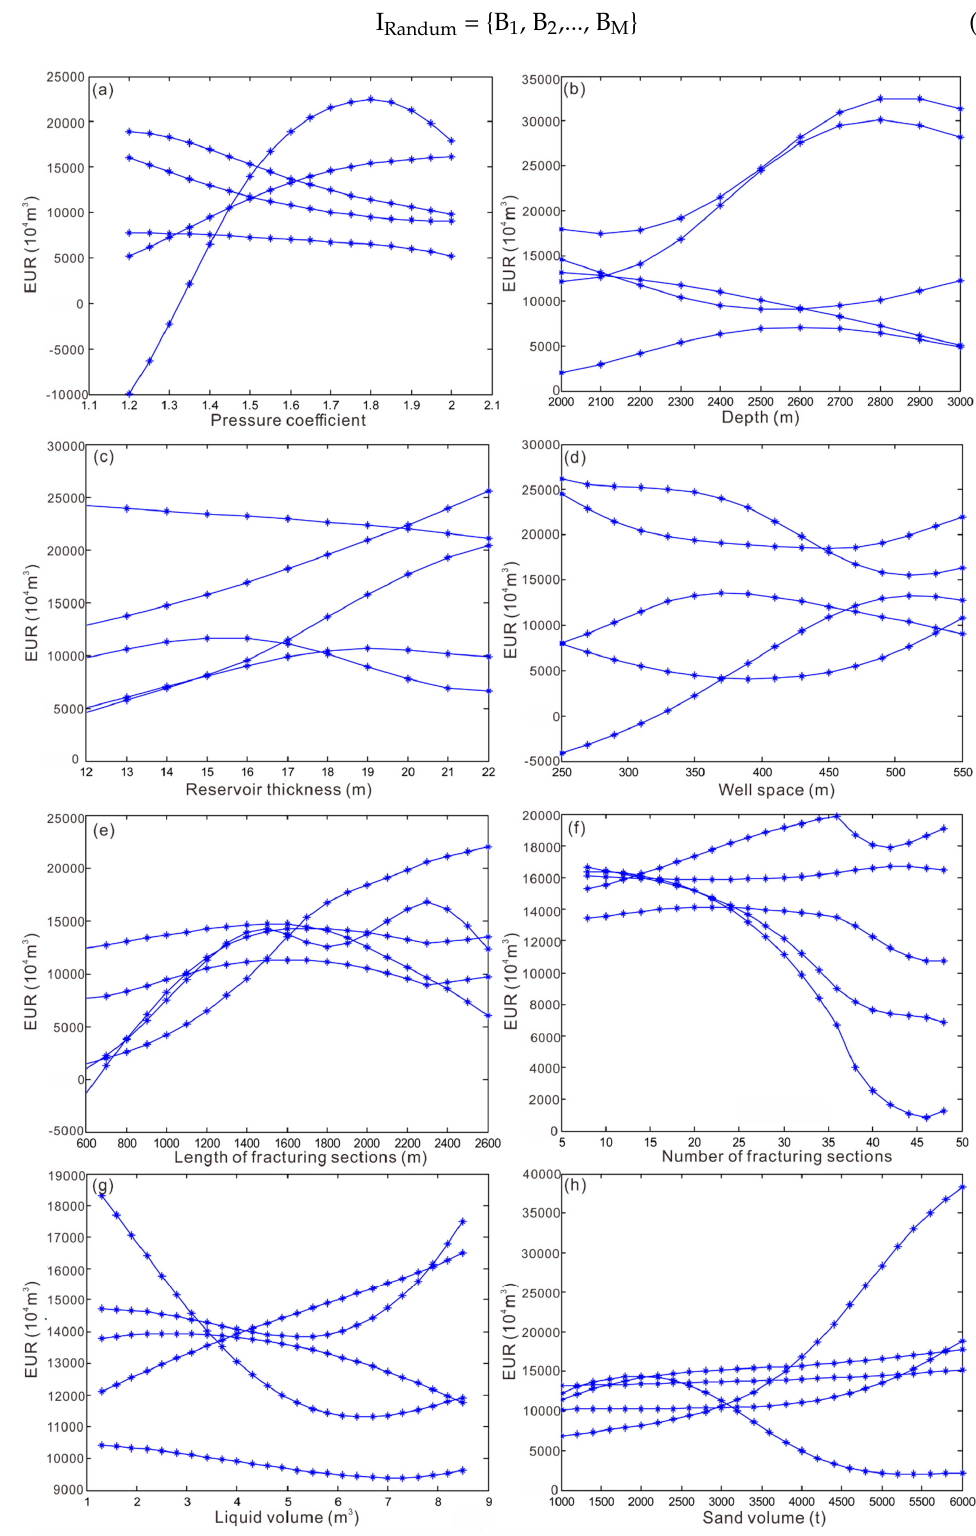
Figure 2. BP neural network analysis of 5 different combinations of the same samples. ( a ) Relation- ships between predicted EUR and pressure coefficient; ( b ) relationship between EUR and depth; ( c ) relationship between EUR and reservoir thickness; ( d ) relationship between EUR and number